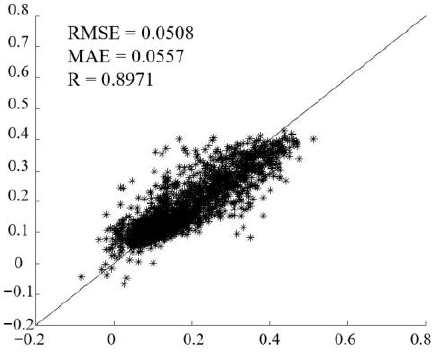
Figure 4. Model testing results of reconstructed NDVI model.